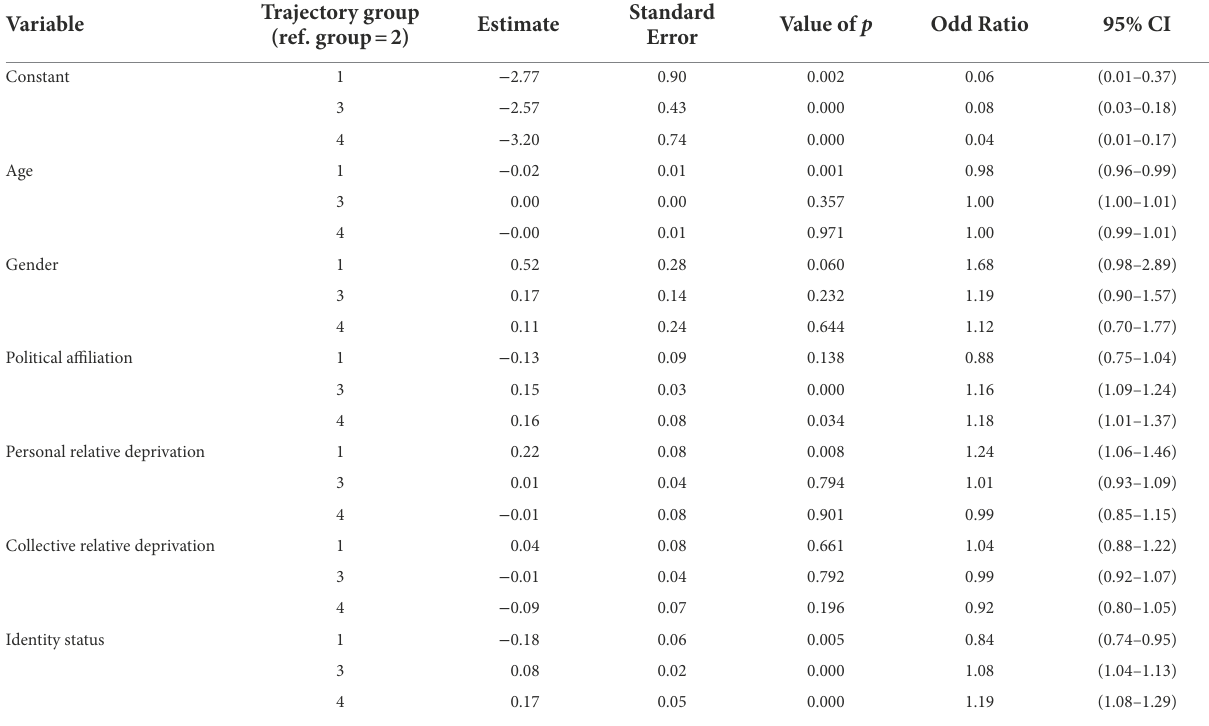
TABLE 7 Antecedents of trajectory group membership of prejudice.